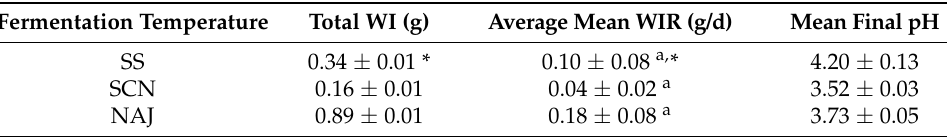
Table 3. Total weight increase (WI) of kefir grains, mean average weight increase rate (WIR), and mean final pH values, during the fermentation of sugary substrates at 24 h fermentation cycles (FC). SS, Sucrose solution; SCN, sour cherry nectar, NAJ, natural apple juice. Values in each column that share the same letter do not differ significantly from each other (Mann–Whitney